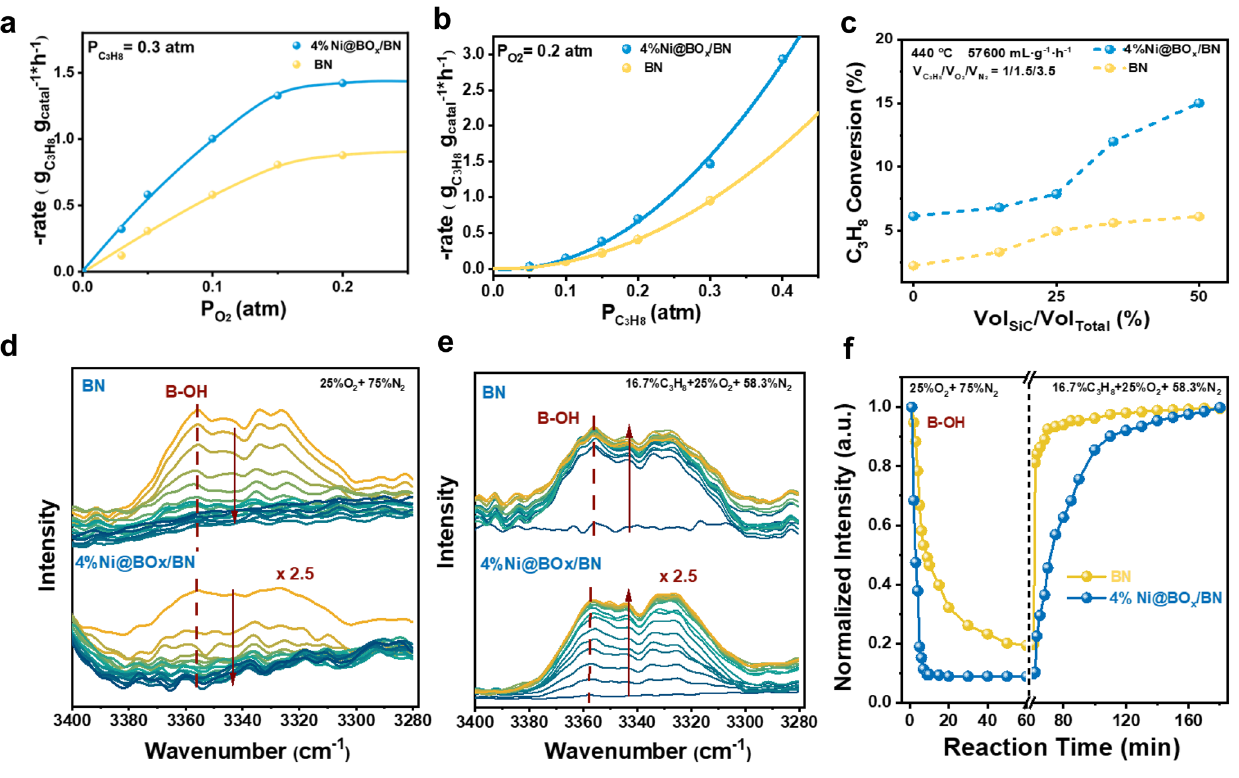
Fig. 3 | Experimental studies of the reaction mechanism of the ODHP reaction over the Ni@BO x /BN catalyst. a Dependence of the reaction rate on p(O 2 ). b Dependenceofthereactionrateonp(C 3 H 8 ). c Thechangeinreactionrateonthe dilution ratio. d , e Time-resolved in situ DRIFTS observation of the B-OH species